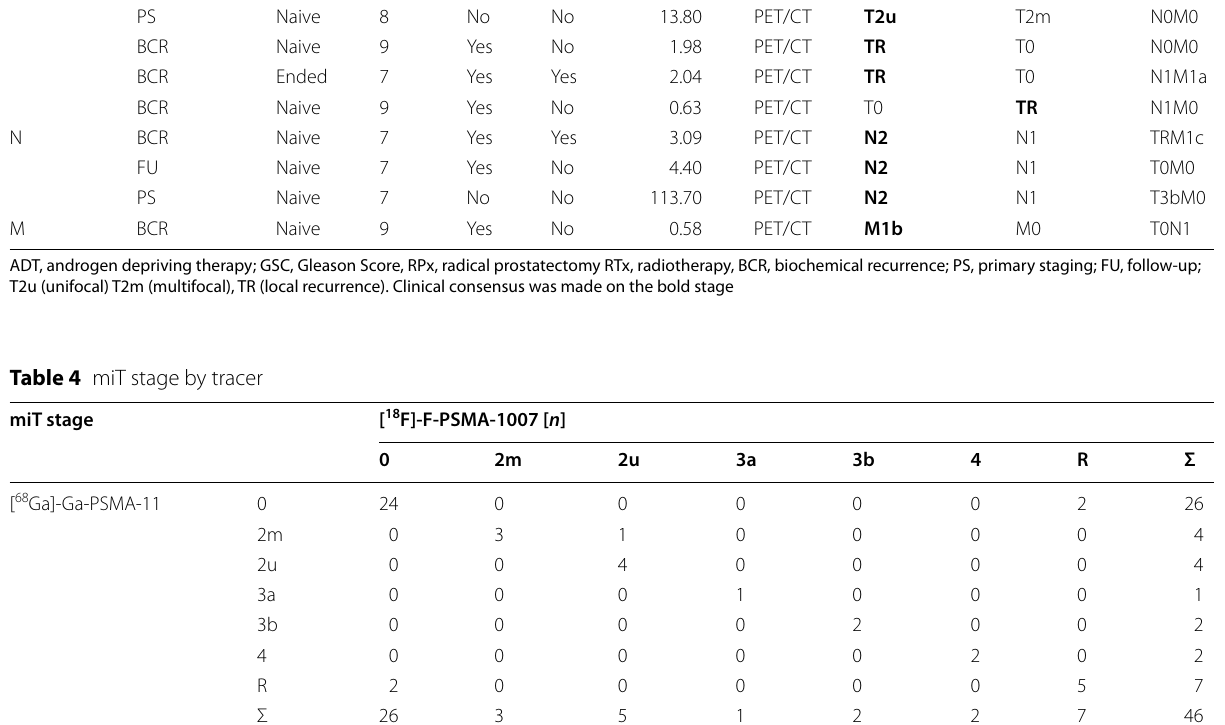
Table 3 Patients with disconcordant miTNM stages